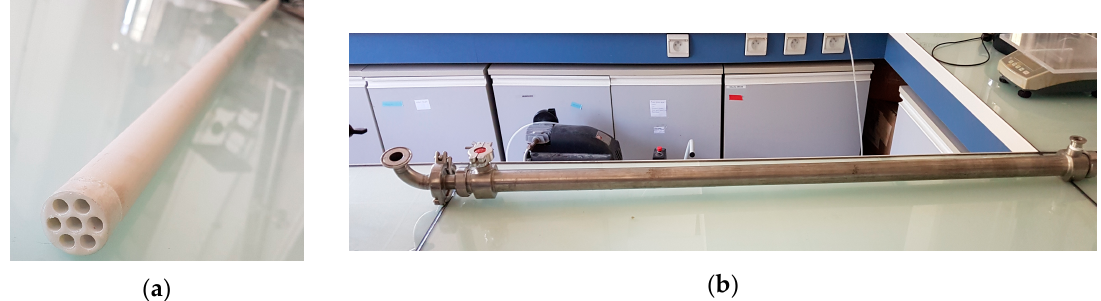
Figure 1. Material membrane used in this study: ( a ) hybrid silica membrane; ( b ) membrane module.